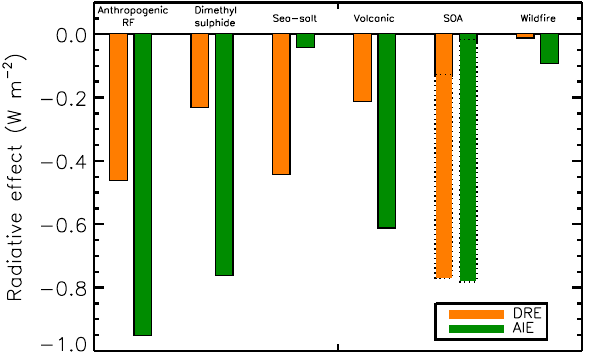
Fig. 12. Comparison of anthropogenic aerosol radiative forcing (RF) and the radiative effects (RE) calculated for natural aerosol sources. The REs for biogenic SOA (dotted bars) are from this study, and all other values are from Rap et al.